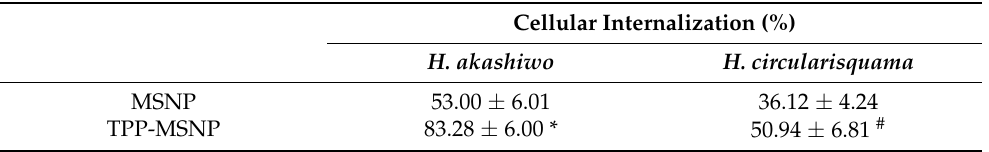
Table 5. Cellular internalization of DP92-loaded MSNP or TPP-MSNP in HABs. Data are presented as mean ± SD ( n = 3). * p < 0.01 compared with MSNP and # p < 0.05 compared with